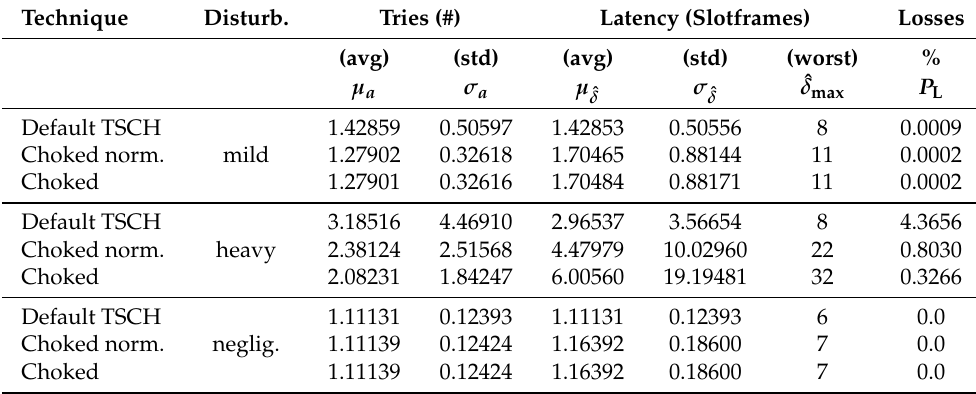
Table 4. Steady-state analysis (mild, heavy and negligible